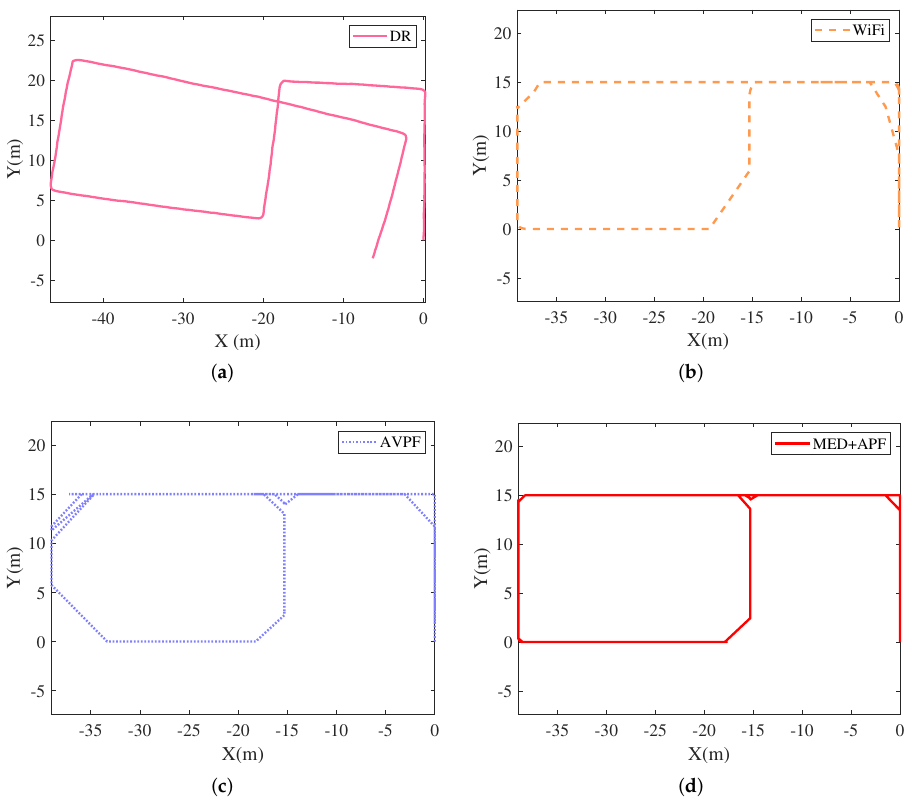
Figure 13. Positioning trajectories with different strategies. ( a ) DR; ( b ) WiFi; ( c ) AVPF [32]; ( d )